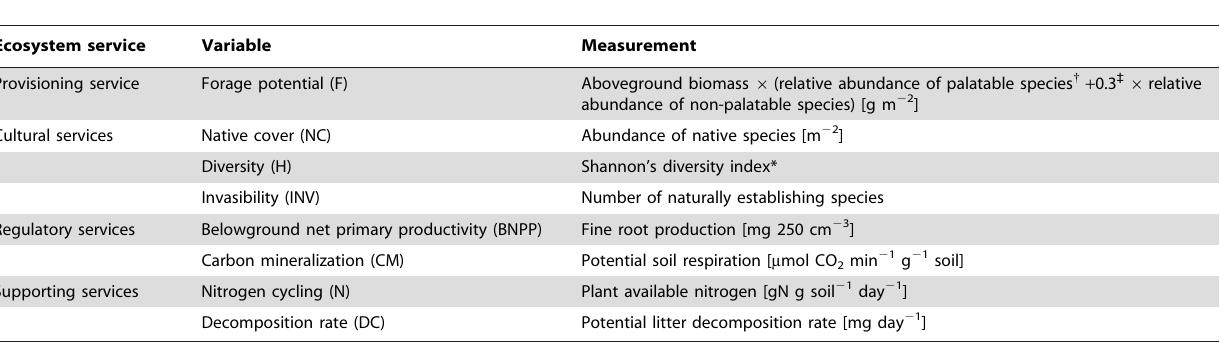
Table 1. Ecosystem service measurements taken in three different grassland ecosystem